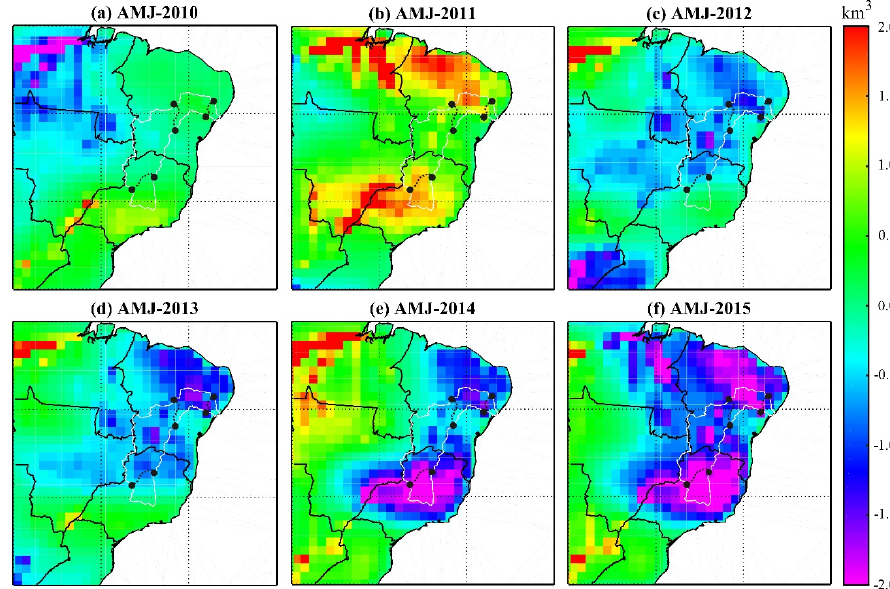
Figure 5. Residual GRACE-derived TWS, in km 3 , averaged during austral falls (AMJ) at the years of 2010 ( a ); 2011 ( b ); 2012 ( c ); 2013 ( d ); 2014 ( e ); and 2015 ( f ) after climatological means were removed. The black dots and the dotted lines show (approximately) the parts of SFRB (see Subsection 2.1.1.) as Upper, Middle, Lower, and the Low parts of SFRB.